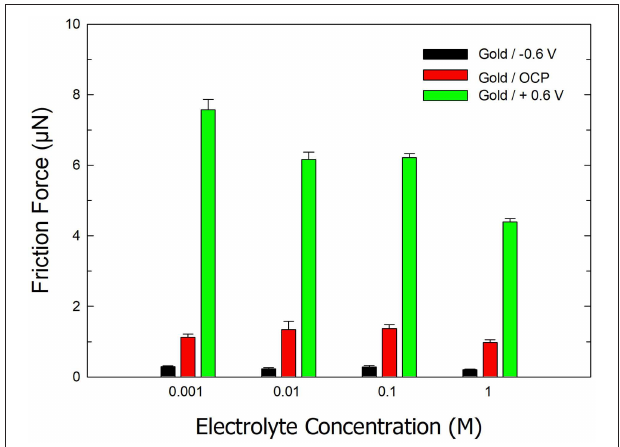
FIGURE 3 | Bar chart of the average friction force on ultra-smooth gold in electrolytes of various salt concentrations under open circuit and applied potentials of − 0.6 and + 0.6V. Error bars indicate standard deviations from 10 repeats. The normal load is 2.5 µ N.